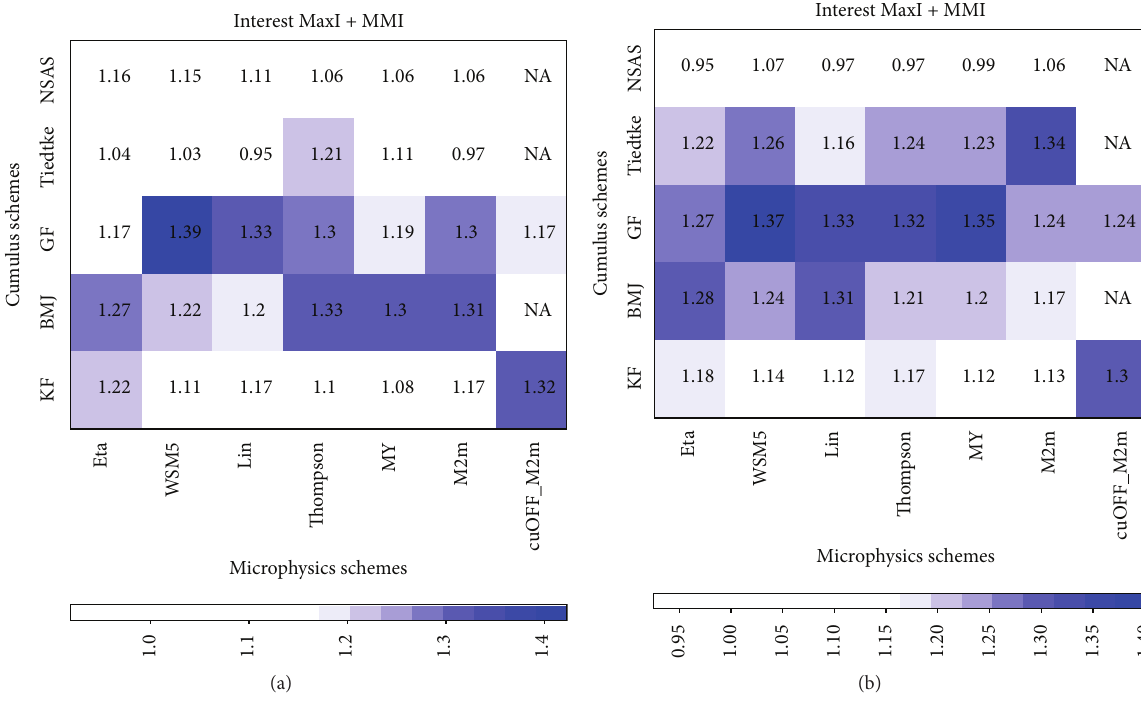
Figure 13: Maximum total interest plus median of maximum total interest distribution for each experiment using a threshold of 0.1mm. Valid for (a) 2000 UTC and (b) 2100 UTC, 1 May